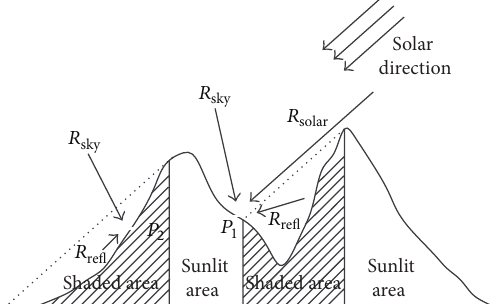
Figure 6: Schematic of the radiations accepted for two points ( 𝑃 1 and 𝑃 2 ) in the shaded area and sunlit area, respectively, for the cross section of a